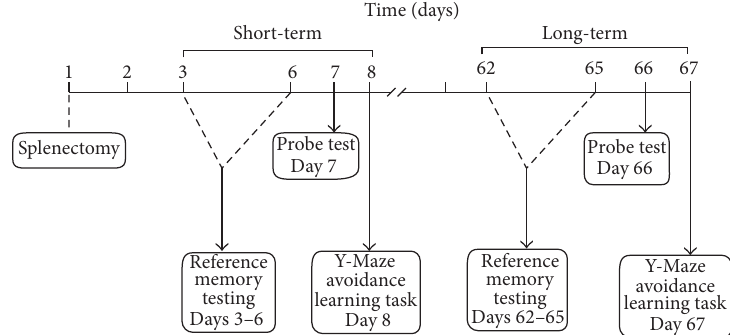
Figure 1: Schematic timeline of the experimental